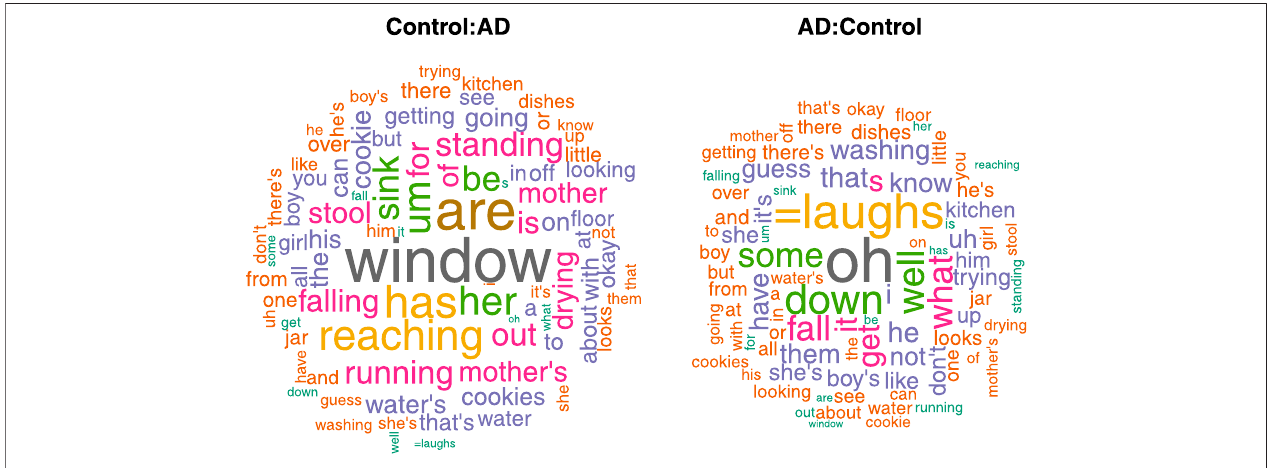
FIGURE 1 | The word cloud on the left highlights words that are more common among control subjects than AD; the word cloud on the right highlights words that are more common among AD than control.